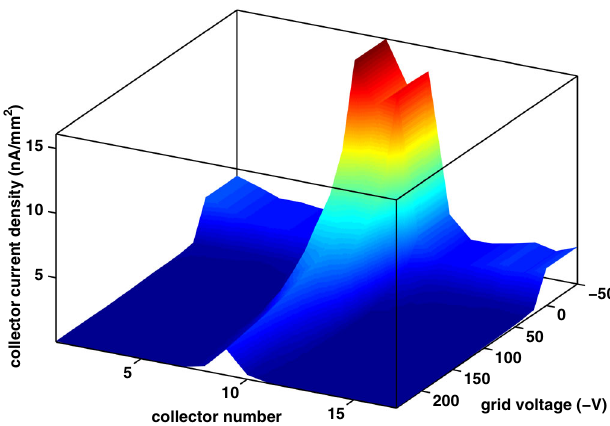
FIG. 11. Example aluminum chicane RFA simulation: 1 × 45 × 1 . 25 mA e þ , 14 ns, 5.3 GeV. Compare to Fig.